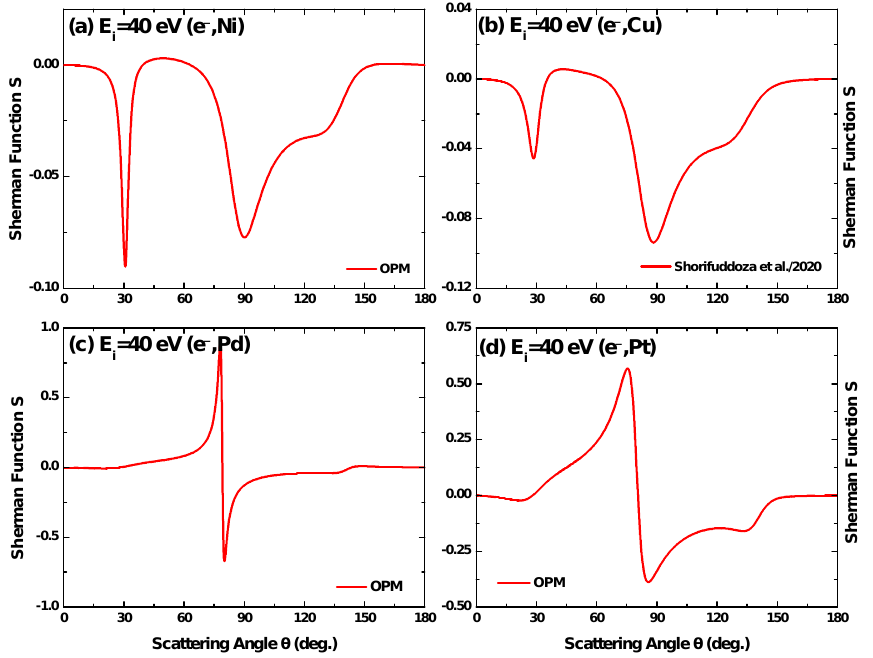
Figure 10. Angular variation of the Sherman function predicted by the OPM approach for electron scattering from ( a ) Ni 58 , ( b ) Cu 63 , ( c ) Pd 108 , and ( d ) Pt 196 at impact energy E i = 40 eV.